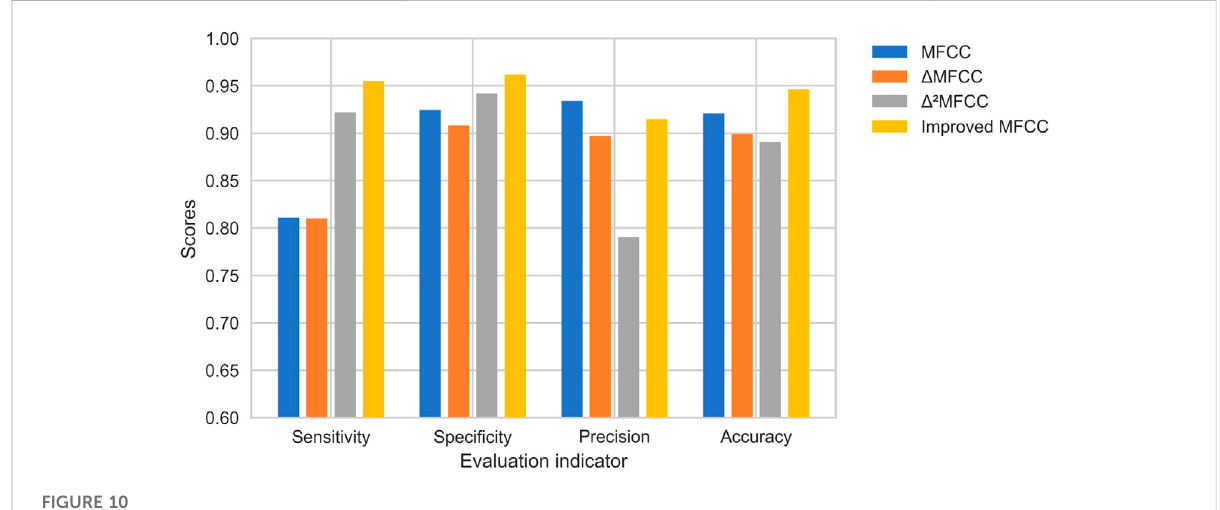
FIGURE 10 Comparison of heart sound features based on the proposed